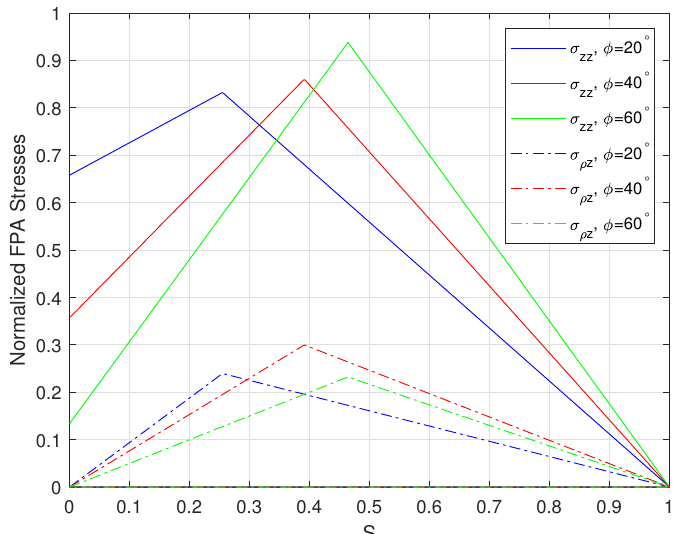
Figure 2. Representative analytical sandpile stresses from the Fixed Principal Axis model ([28,29]). Normal stress σ zz is plotted alongside the corresponding radial shear stress σ ρ z for three values of the angle of repose φ ; values are plotted with respect to a normalized coordinate S = the location of the peak stress magnitudes is a function of φ